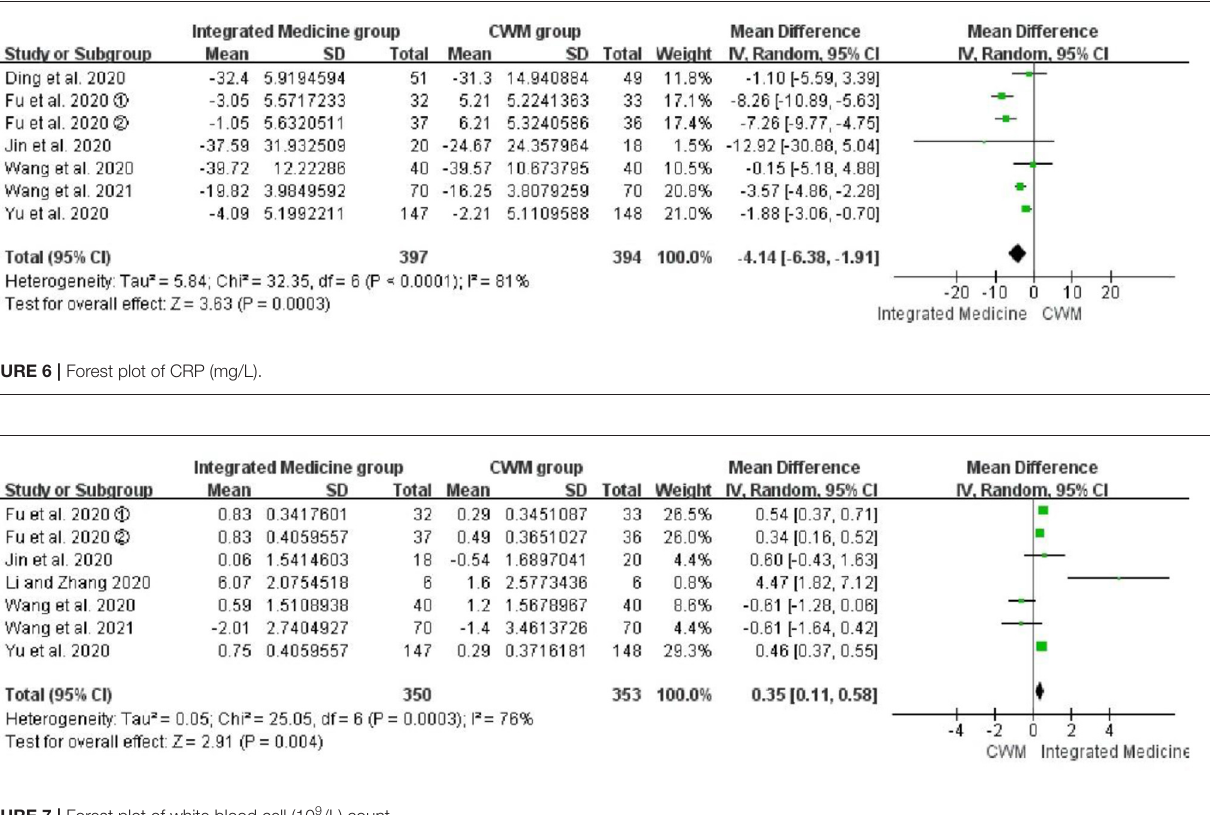
disappearance rate: z = 1.50, P = 0.133; cough disappearance rate: z = 0.62, p = 0.536; CRP: z = 0.30, p = 0.764; WBC: z = 0.60, p =